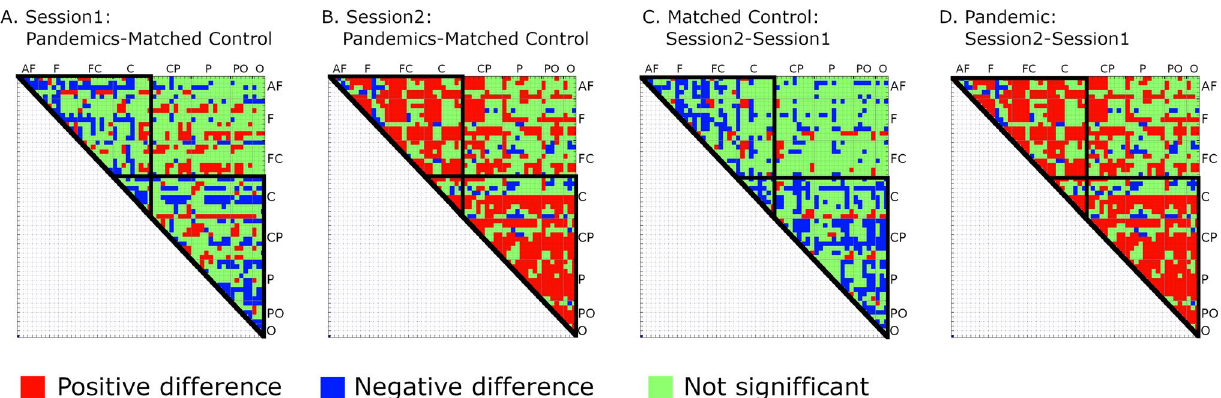
Figure 6. Comparison of differences for all PLV pairs measured between Pandemic and Matched Control groups and between sessions for these groups, in an exemplary beta-2 band. ( A ) Differences between all PLVs for Pandemic and Matched Control groups in Session-1 performed for both groups before the pandemic outbreak; ( B ) the same for Session-2 which was performed for Matched Control group before the pandemic outbreak, and for Pandemic group during lockdown; ( C ) differences between all PLVs measured in Session-2 and Session-1 for Matched Control group, both sessions performed before pandemic outbreak; ( D ) Differences between Session-2 (performed during lock-down) and Session-1 (before the pandemic outbreak) for Pandemic group. Black triangular outlines denote frontocentral and centroparietal PLV values with the most